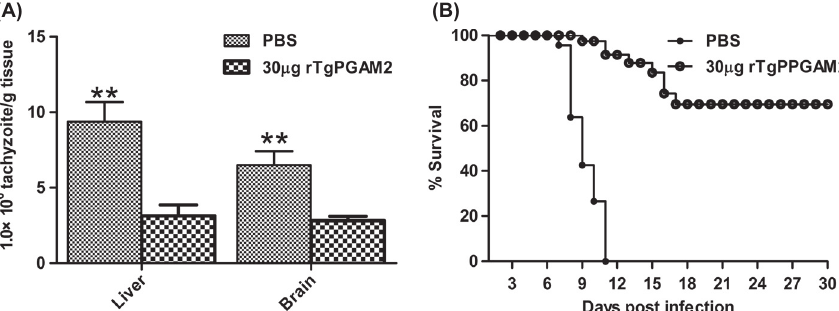
Figure 4. Protection of BALB/c mice against Toxoplasma infection. Six-week-old mice (20/group) were intranasally immunised on days 0, 14, 21 with 30 l g of rTgPGAM 2 or PBS as a control. (A) Two weeks after the last booster, the mice were challenged by gavage with 1 · 10 4 tachyzoites of the T. gondii RH strain. Thirty days after the challenge, brain and liver tachyzoites were enumerated using q-PCR assay. The results are expressed as the mean ± SD ( n = 8) and represent the numbers of tachyzoites in 1 g of tissue. ** P < 0.01 (vaccinated vs. PBS group). (B) Two weeks after the last booster, the mice (12/group) were challenged with 4 · 10 4 tachyzoites of T. gondii via the oral route. Survival was monitored and recorded daily for 30 days after challenge. Control mice immunised with PBS died within 11 days, and the mice immunised with rTgPGAM 2 died from days 9 to